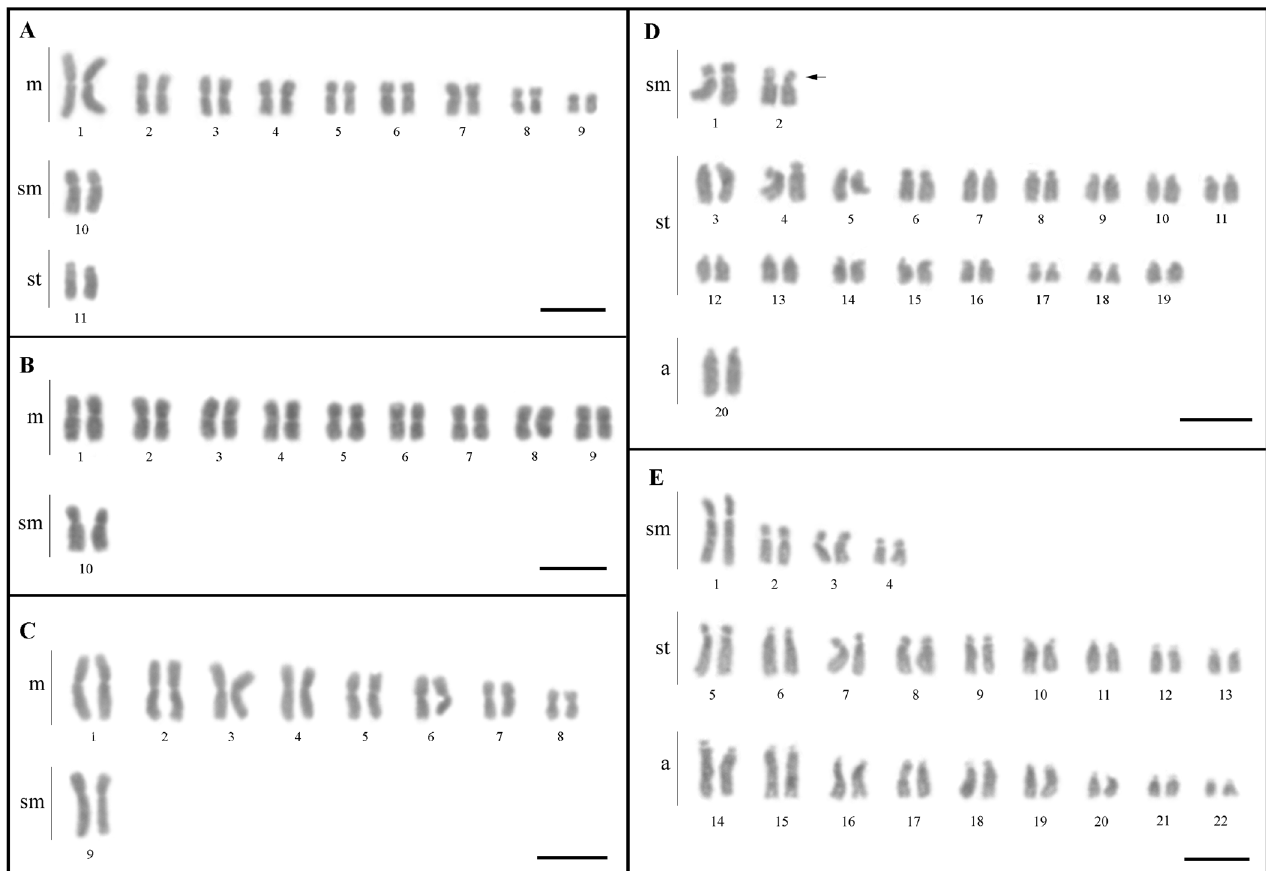
Fig 2. Female karyotypes of ant species from the Atlantic rainforest: (A) Pheidole germaini (2n=22), (B) Pheidole sp. ( flavens group) (2n=20), (C) Brachymyrmex admotus (2n=18), (D) Camponotus atriceps ( 2n=40), and (E) Odontomachus haematodus (2n=44). The arrow in (D) indicates the secondary constriction in pair 2. Scale bars = 5